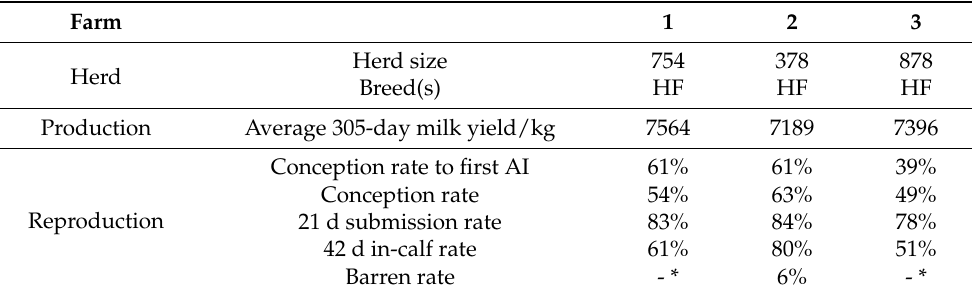
Table 1. Herd, production and fertility information of the enrolled farms. Farm 1 Herd Herd